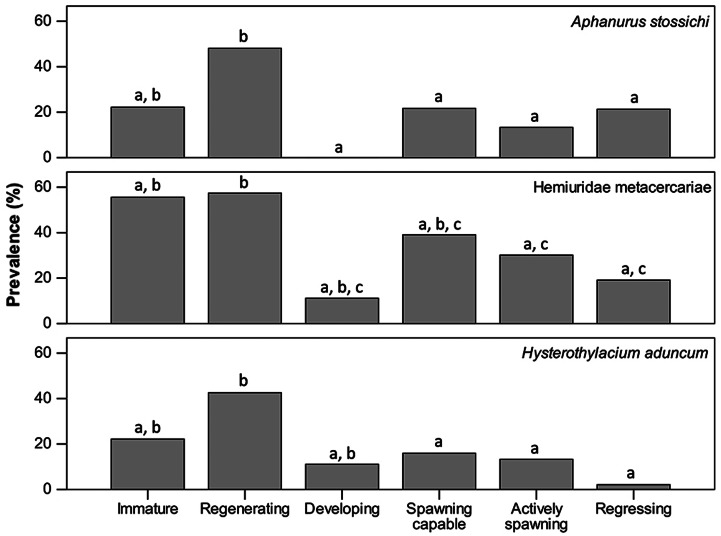
Prevalences (PP) of parasites in relationship to the different ovarian developmental phases of anchovies. Significant differences among groups (Fisher’s exact test, P < 0.05) are indicated with different letters.